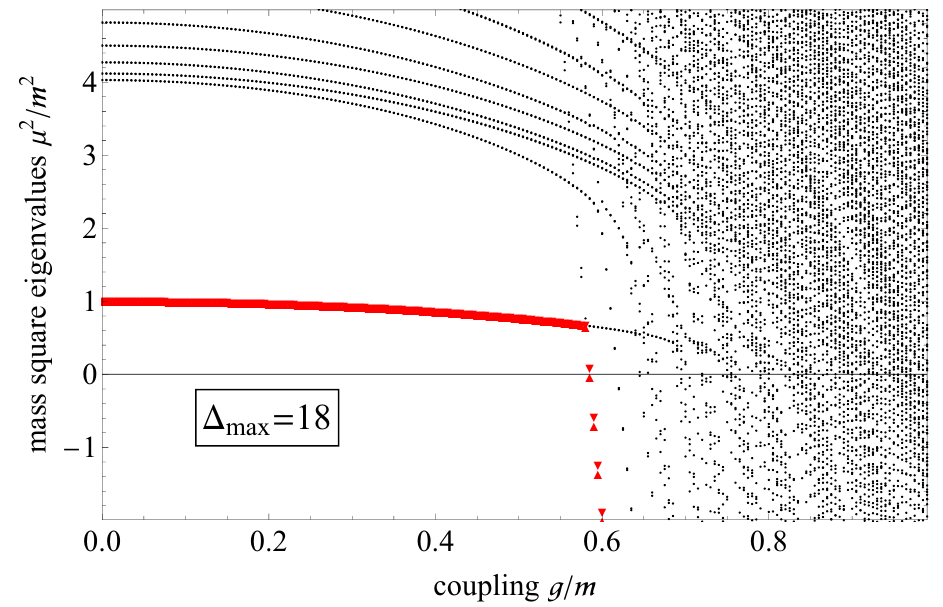
Figure 2 . Life is hard when using P + . The eigenvalues of P + at ∆ max = 18 are shown above, with the two lowest states highlighted in red. They are (almost) exactly paired by the supercharge Q − . Near g ≈ 0 . 6, states come from the top of the spectrum and rapidly go to negative mass squared eigenvalues. This sharp drop in the smallest eigenvalue is characteristic of a first order phase transition, which we reach before the critical